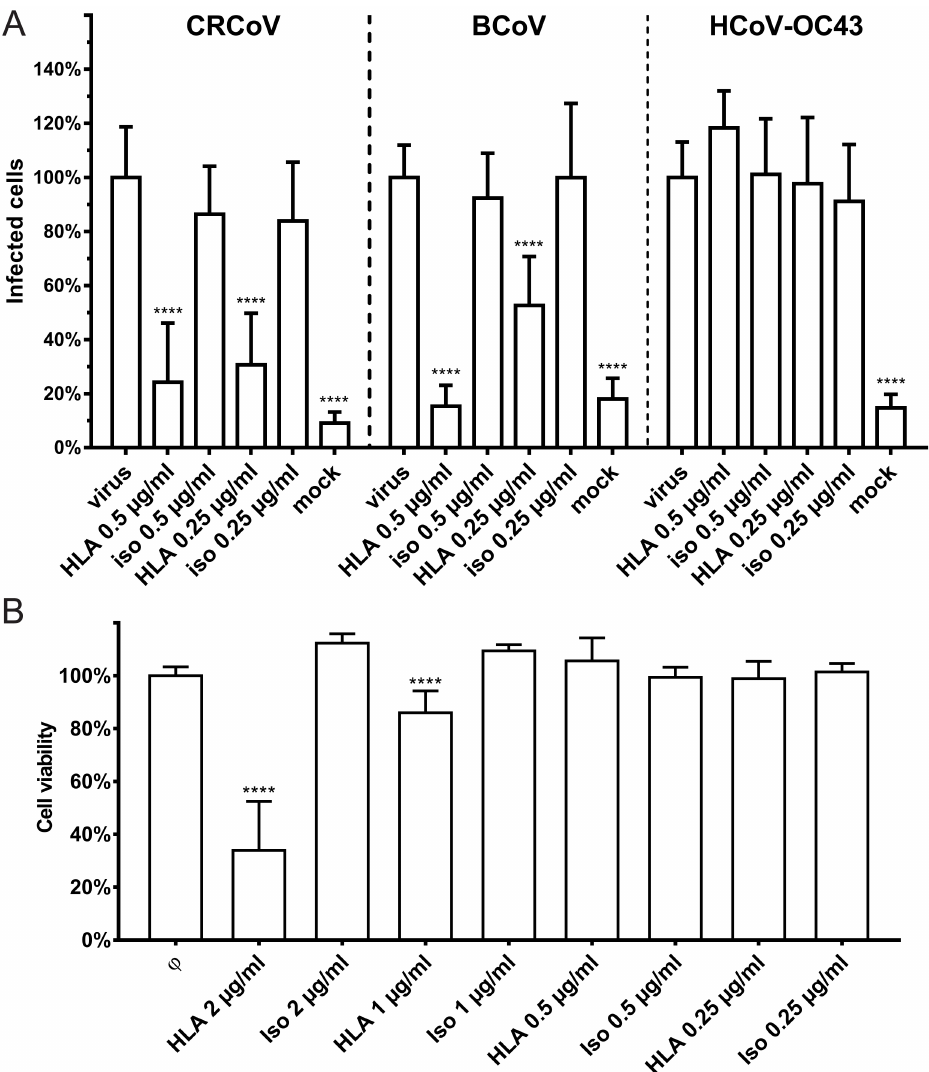
Figure 10. Human leukocyte antigen (HLA) class I as entry receptor for betacoronaviruses. Cells infected with HCoV-OC43 VR-1558, BCoV and CRCoV (at TCID 50 of 400 per milliliter, which approximately corresponds to M.O.I. = 0.0007) in the presence of HLA class I antibodies were incubated for five days at optimal temperature. ( A ) The proportion of virus infected cells determined with flow cytometry normalized to control. ( B ) Cytotoxicity of antibodies determined with XTT assay. All data is presented as mean ± SD. (* p < 0.05; ** p < 0.01; *** p < 0.001; **** p <